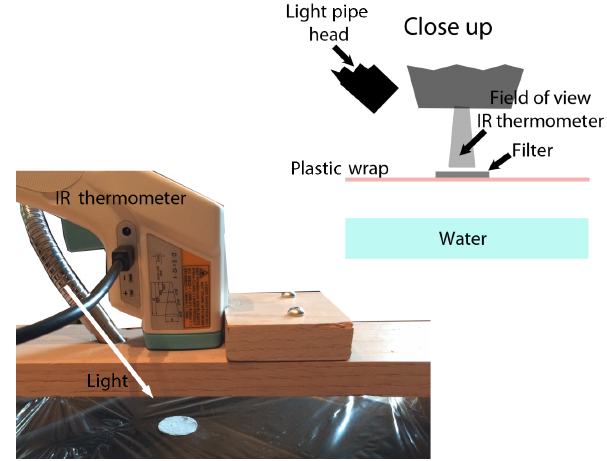
Figure 1. Diagram of the LAHM analysis setup. A light source is aimed at a 45 ◦ angle at the filter which rests on plastic wrap approx- imately 10cm above the water surface. The infrared thermometer directly views the center of the filter. The field of view of the ther- mometer is approximately 1.5cm at the distance of the filter and the contaminant spot on the filter is generally 2cm in